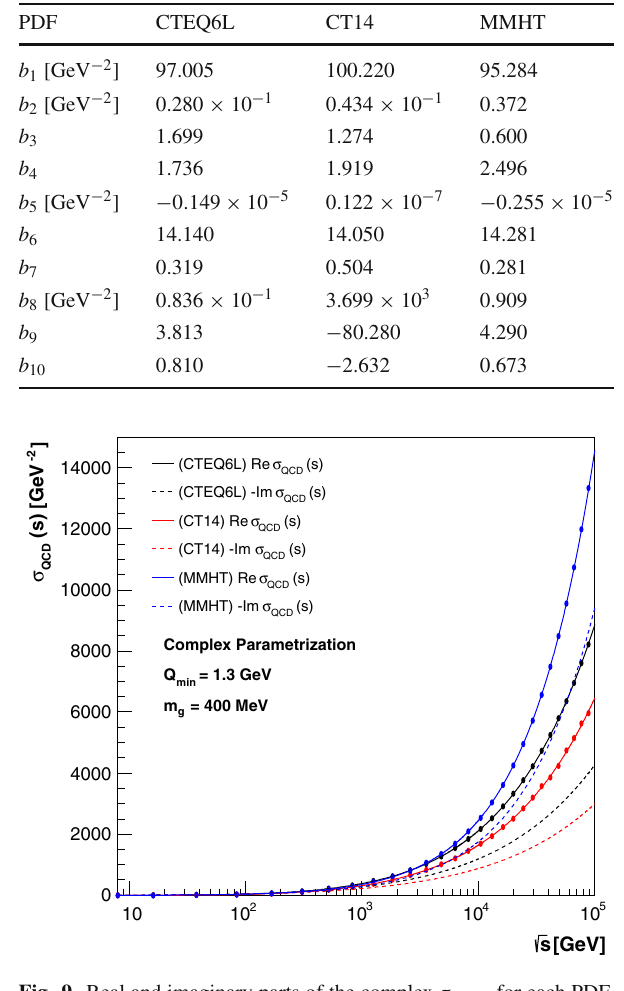
Table 10 Fit results by enlarging the uncertainties in the TOTEM data on σ tot at 8 TeV and 13 TeV by factors